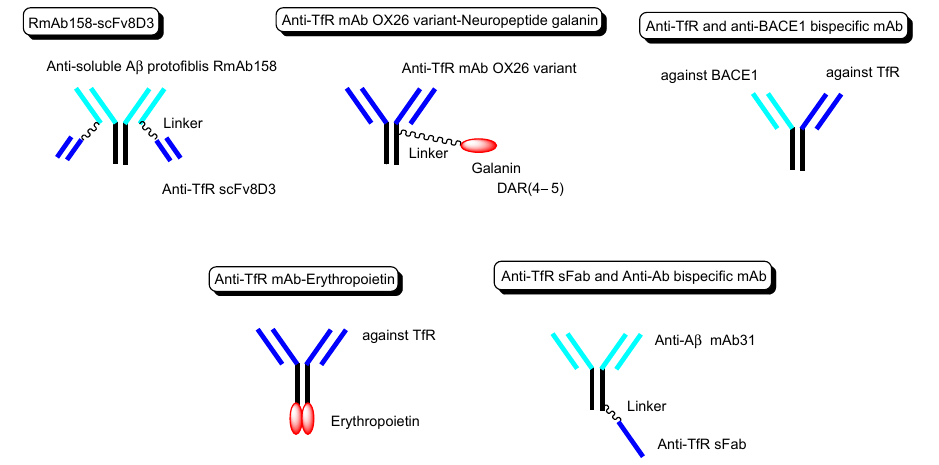
Figure 6. The structures of anti-TfR mAbs, conjugated to active cargos.